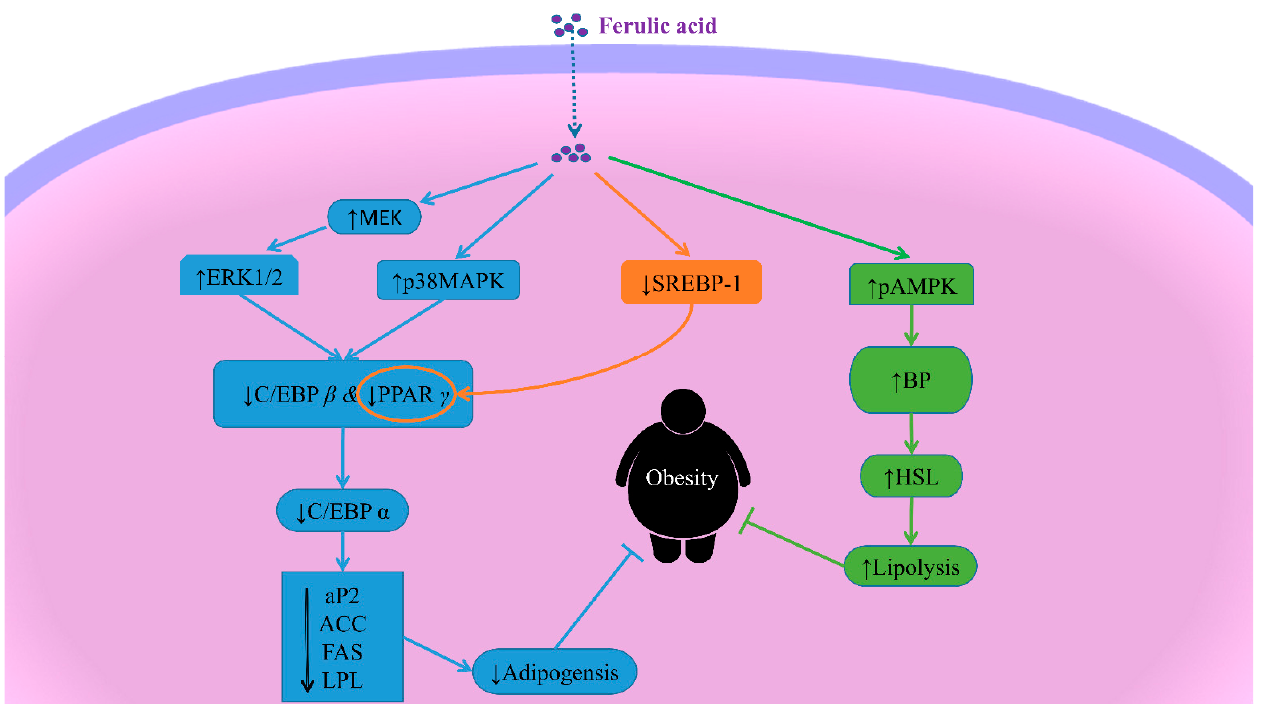
Figure 3. The molecular mechanism of ferulic acid improving obesity. Note: ↑ : activate/upregulate; ↓ : inhibit/downregulate; ERK: extracellular signal-regulated kinase; MAPK: Mitogen activated protein kinase; PPAR γ : peroxisome proliferator-activated receptor γ ; C/EBP: CCAAT/enhancer-binding protein; SREBP-1: sterol regulatory element-binding protein-1; ACC: acetyl-CoA carboxylase; aP2: adipocyte binding protein; FAS: fatty acid synthase; LPL: lipoprotein lipase; AMPK: AMP-activated protein kinase; BP: beta-adrenergic receptor.